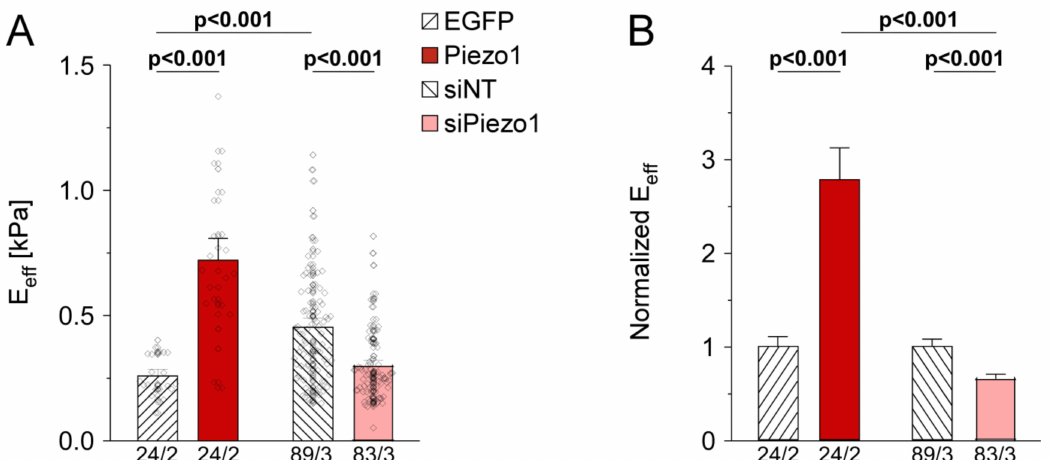
Figure 4. Piezo1-induced stiffening in human atrial fibroblast line (HAF). ( A ) average stiffness of cells 3 days after transfection of expression constructs for overexpression of EGFP or Piezo1, non-targeting siRNA (siNT) or siRNA for knock-down of Piezo1 (siPiezo1). ( B ) data from ( A ) normalized by the mean of the respective control group (EGFP for overexpression, siNT for knock-down). n/N = number of cells/number of